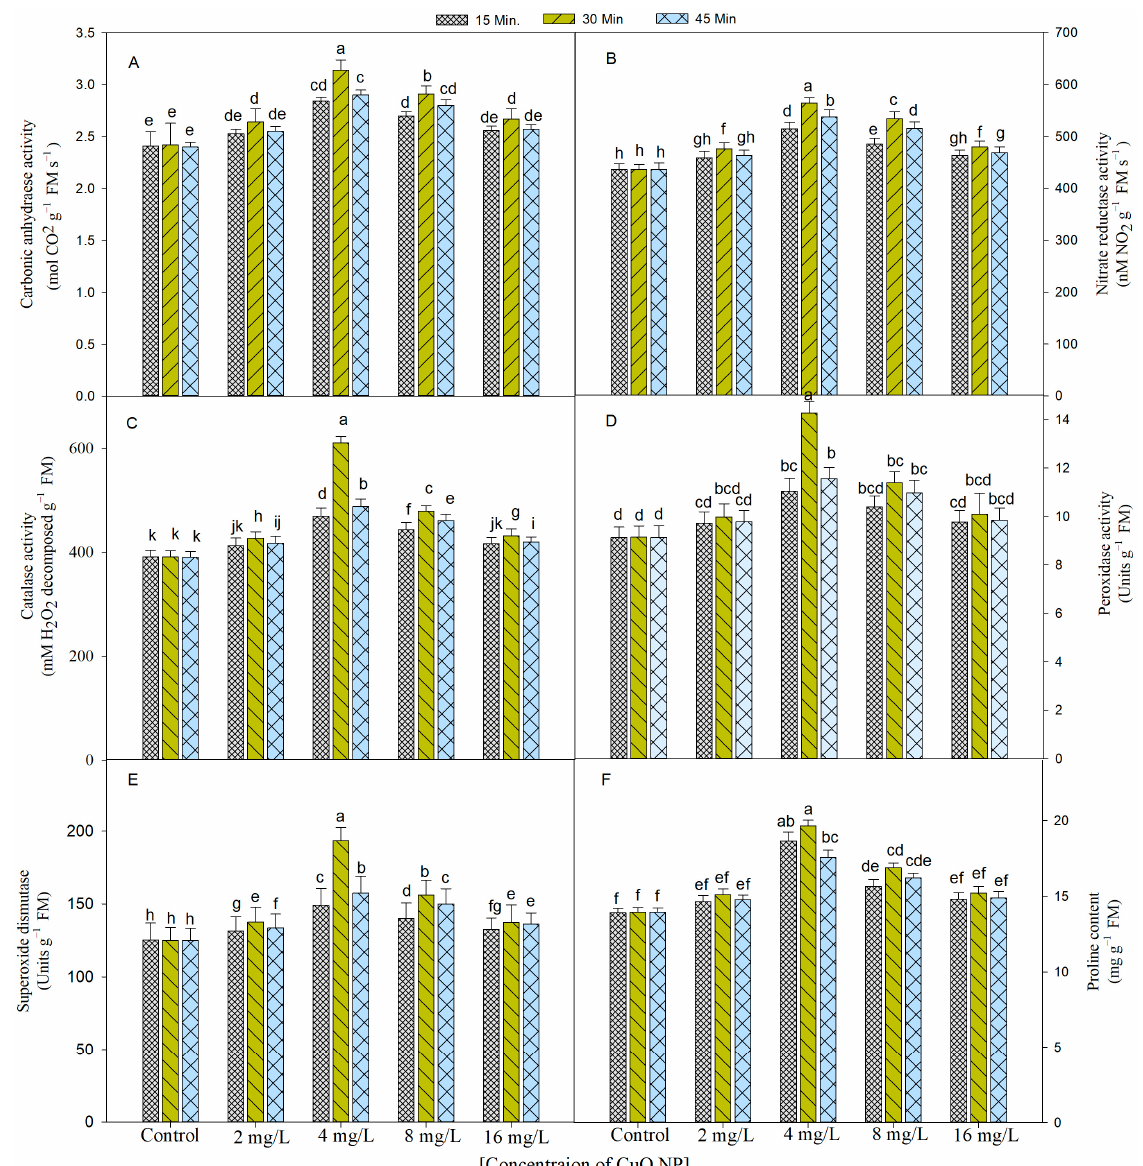
Figure 3. Graph shows the outcome of CuO NPs on the activity of carbonic anhydrase ( A ) and the activity of nitrate reductase ( B ), catalase ( C ), peroxidase ( D ), superoxide dismutase ( E ), and proline content ( F ) in Brassica juncea at 45 DAS. The entire set of data shows the average of five replicates ( n = 5); significant differences between control and treatment and among treatments were represented by different letters and standard error (±SE) was represented by vertical bars.